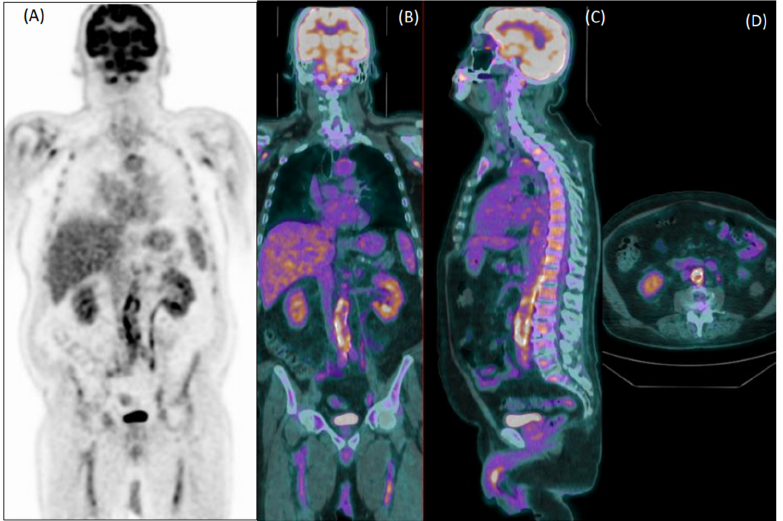
Figure 1. Coronal [ 18 F]FDG PET ( A ) and fused PET/CT coronal ( B ), sagittal ( C ) and axial ( D ) images of an 80-year-old male patient with fever of unknown origin. Images show diffuse increased uptake in the abdominal aorta, common iliac, and femoral arteries. Both readers evaluated this exam as positive for vasculitis, which was confirmed during clinical follow-up.